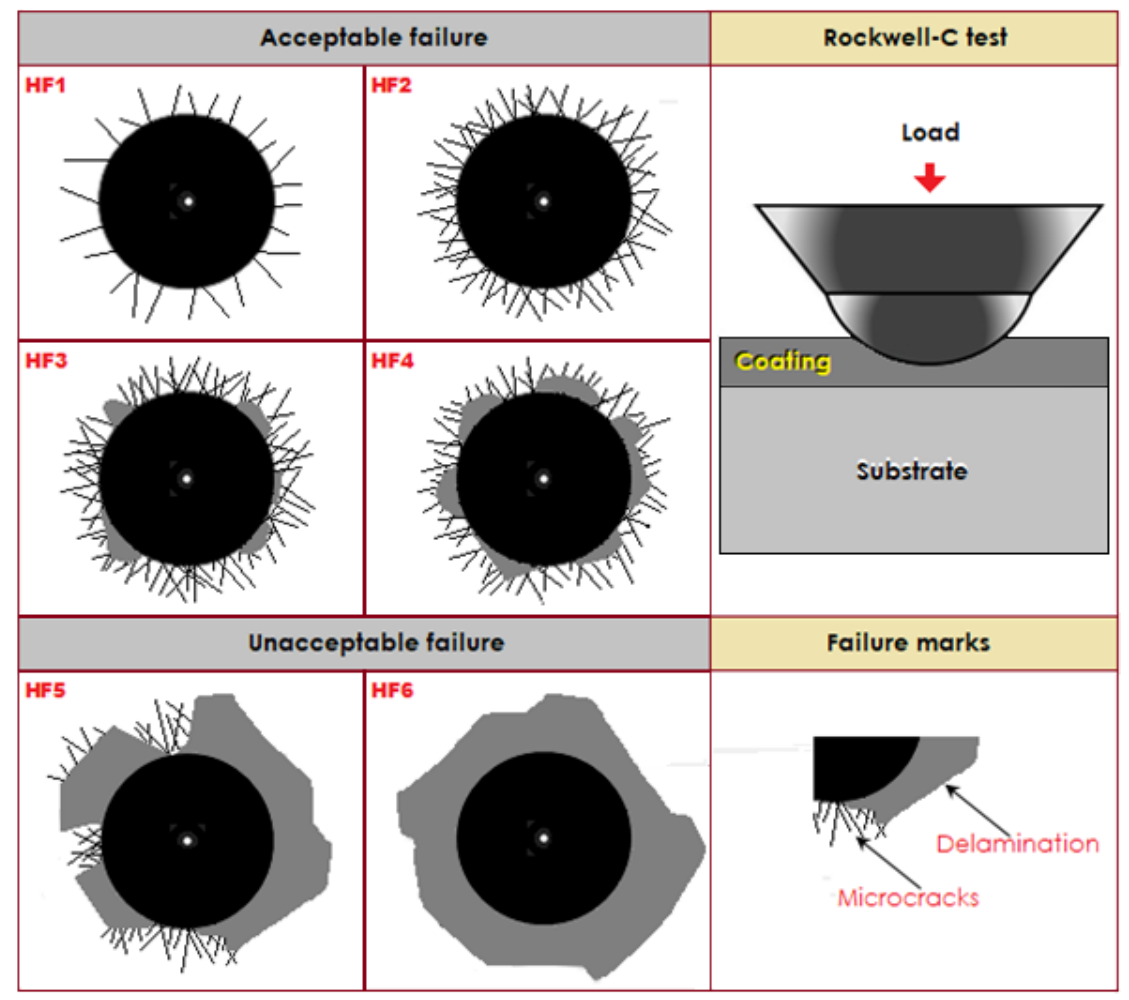
Figure 9. Different cohesive strength quality configurations to assess the cohesion of the boronized layer attached to the substrate by Rockwell-C indentation test.